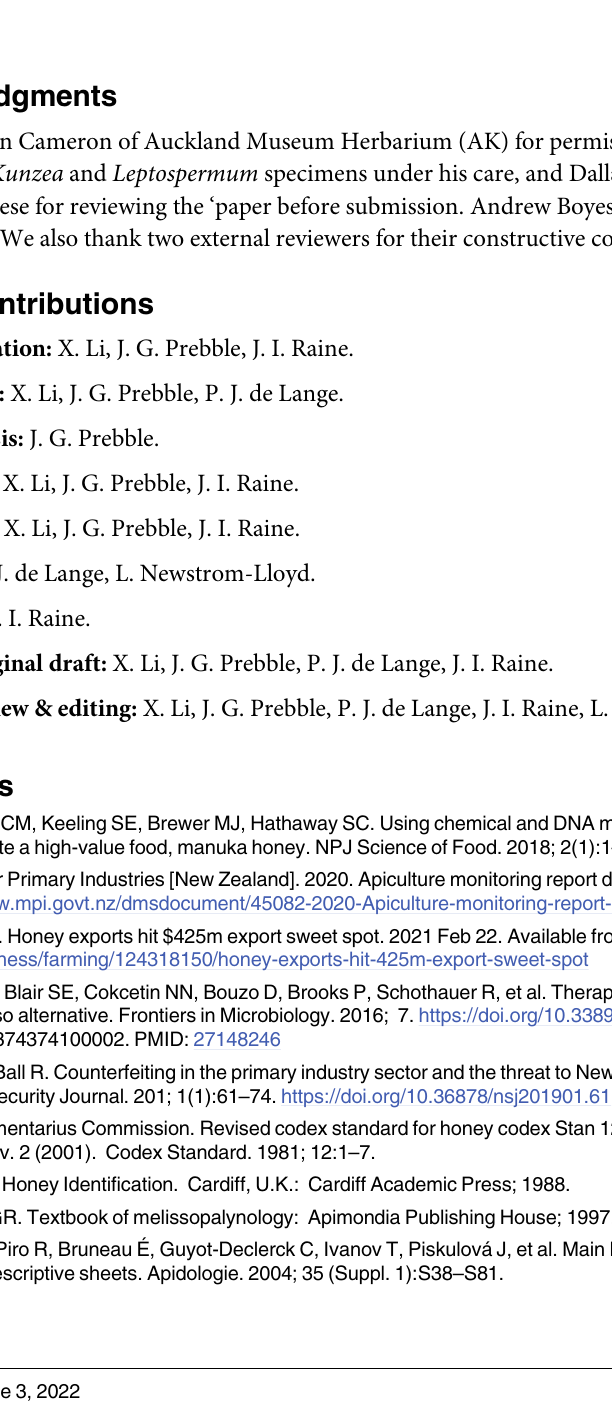
S2 Table. Herbarium specimens studied– Kunzea . S3 Table. Pollen measurements of Leptospermum scoparium s.l. S4 Table. Pollen measurements of Kunzea . S5 Table. Pollen features extracted by Classifynder including 7 core parameters and 43 additional